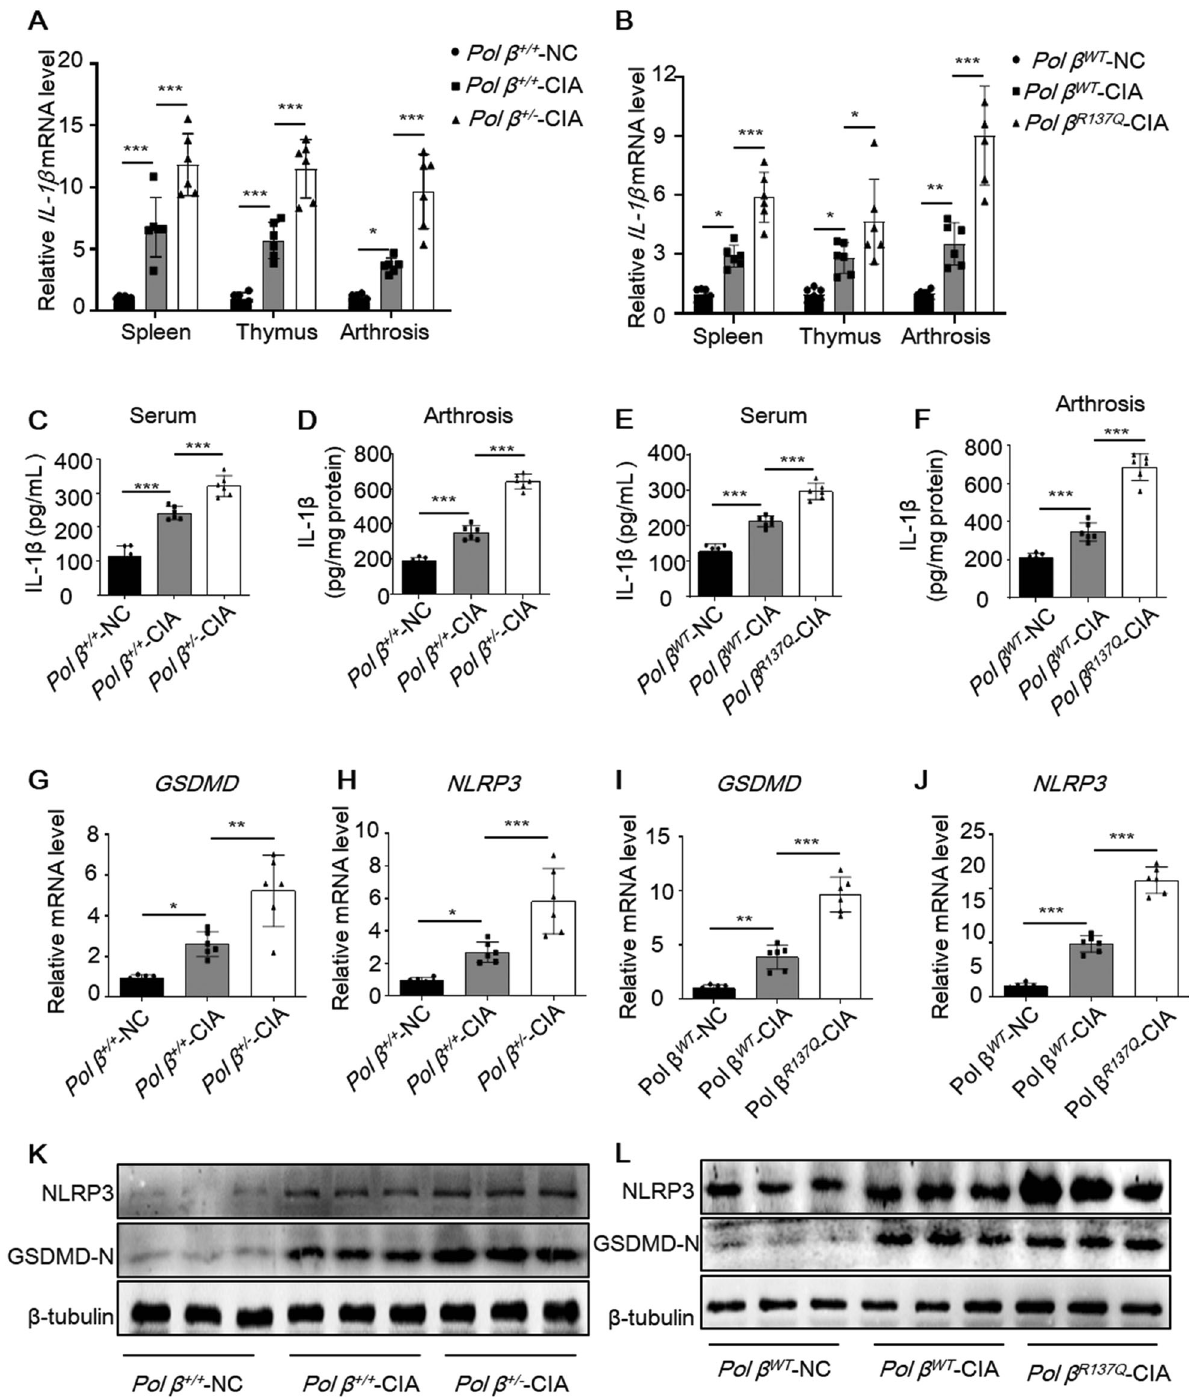
Fig. 2 Pol β de fi ciency exacerbates the in fl ammatory response and pyroptosis in CIA mice. A , B qRT-PCR analysis of IL-1 β mRNA expression in the spleen, thymus, and arthrosis of control and CIA mice. Data points indicate individual mice. Data present mean ± SD from at least